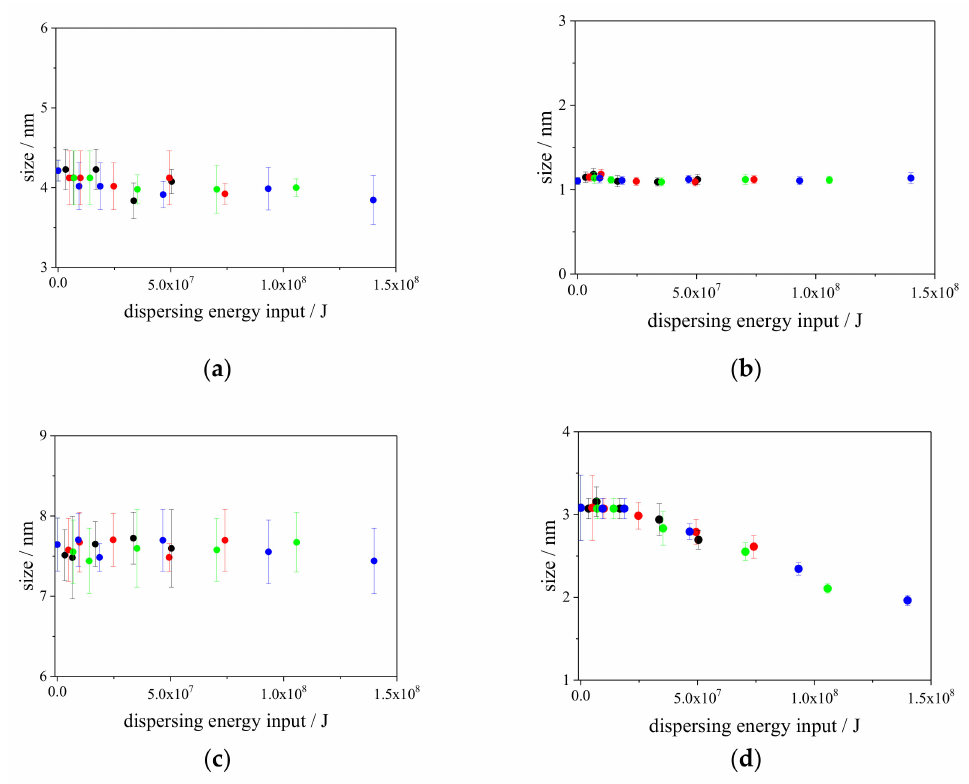
Figure 6. Plots of the micellar sizes of various surfactants in aqueous media as functions of the dispersing energy input, as determined by PFG-NMR. ( a ) Triton X-100, ( b ) SDS, ( c ) Softanol-70, and ( d ) CTAB were used as surfactants. The plots are for different pressures in the narrow channel (80 MPa: black, 120 MPa: red, 180 MPa: green, and 240 MPa: blue). The uncertainties of the diffusion coefficients were calculated according to